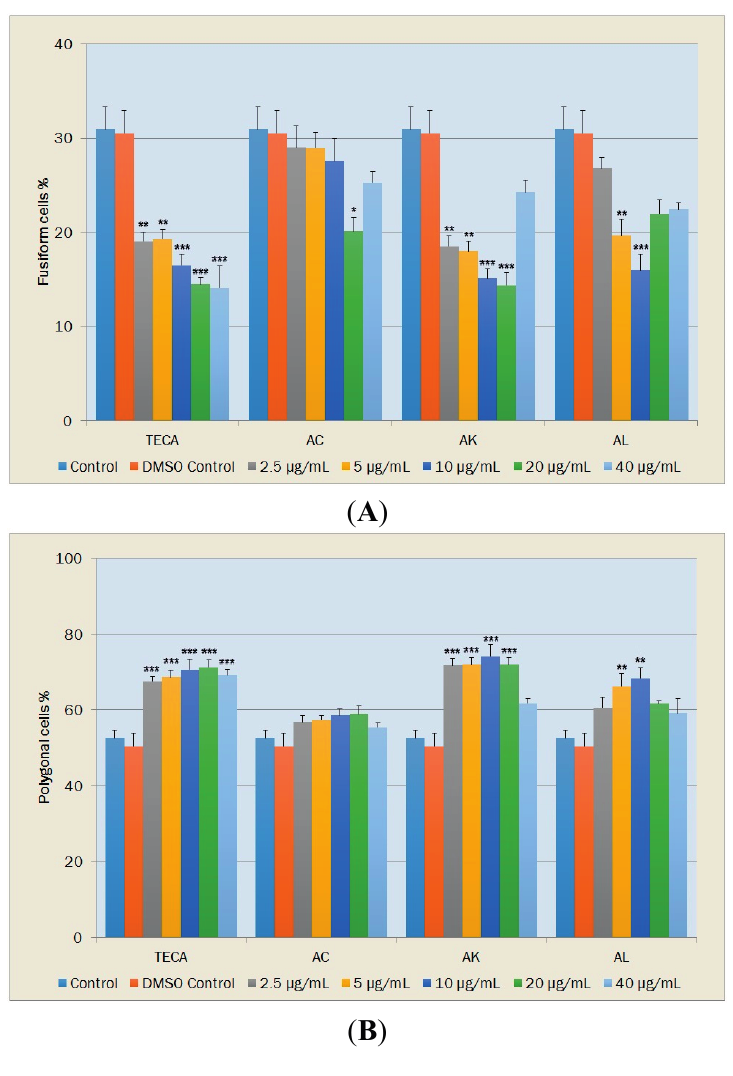
Figure 6. Effects of TECA, AC, AK and AL extracts on percentages of NIH-3T3 fibroblasts in fusiform ( A ); and polygonal ( B ) shapes. Data are mean ± SEM values ( n = 5, in each case). * p < 0.05, ** p < 0.01, *** p < 0.001, significantly different from control